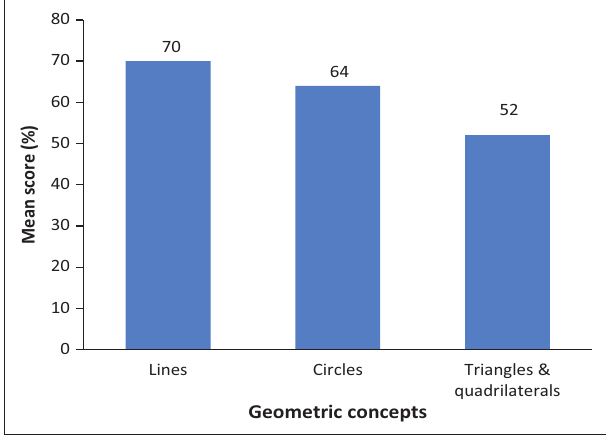
FIGURE 3: Performance of entry level mathematics education students in the multiple choice questionnaire according to concepts.